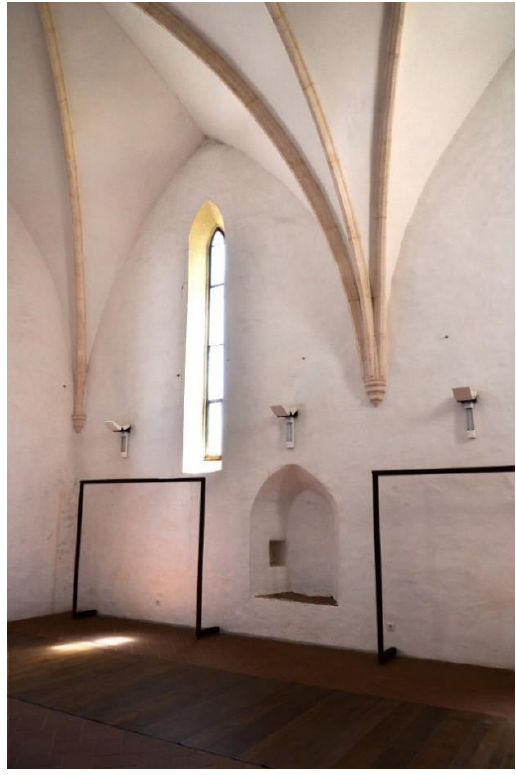
Figure 6. View of the southern wall with the niche and part of the floor covered by wooden beams. Interior. Photo: Janez Premk.